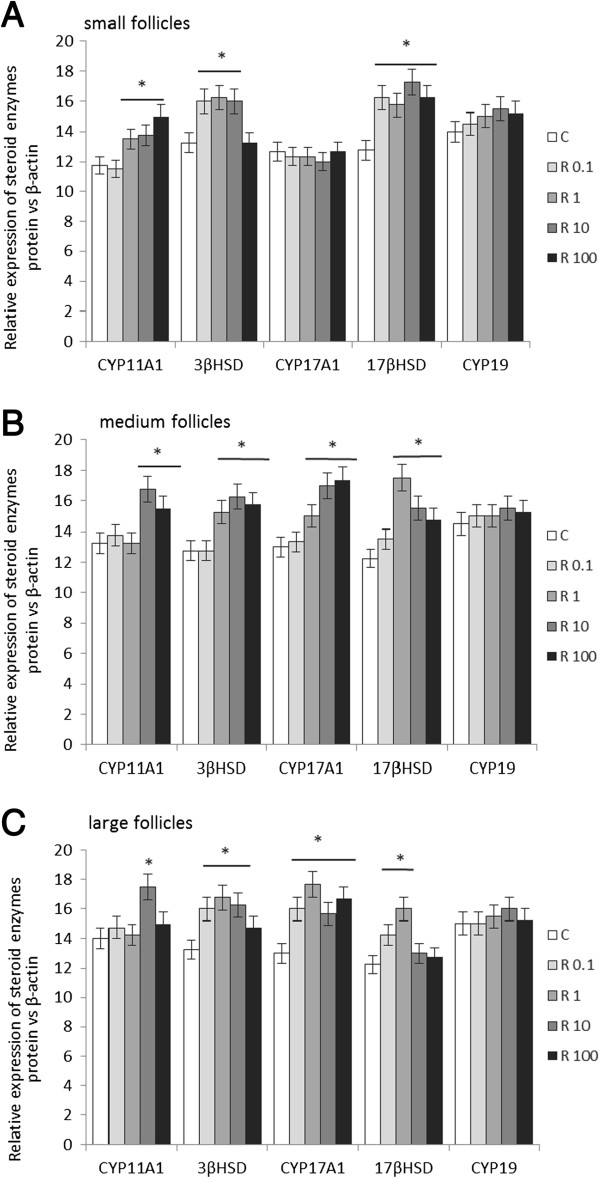
Densitometric analysis of the protein levels of steroidogenic enzymes CYP11A1, 3βHSD, CYP17A1, 17βHSD, and CYP19 in A) small, B) medium and C) large ovarian follicles. Proteins were densitometrically scanned and normalized against β-actin. Western blot experiments were repeated three independent times using samples from three different animals. Data were plotted as mean±S.E.M. Statistical significance is indicated by * P < 0.05.